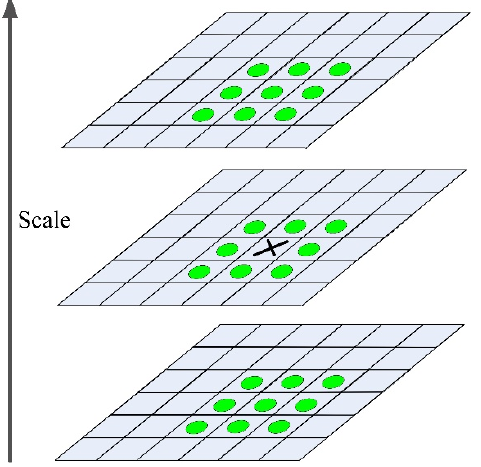
Figure 6. Determination of feature points. The pixel marked “x” in the middle layer is the feature point of the area whose value is greater than green points.